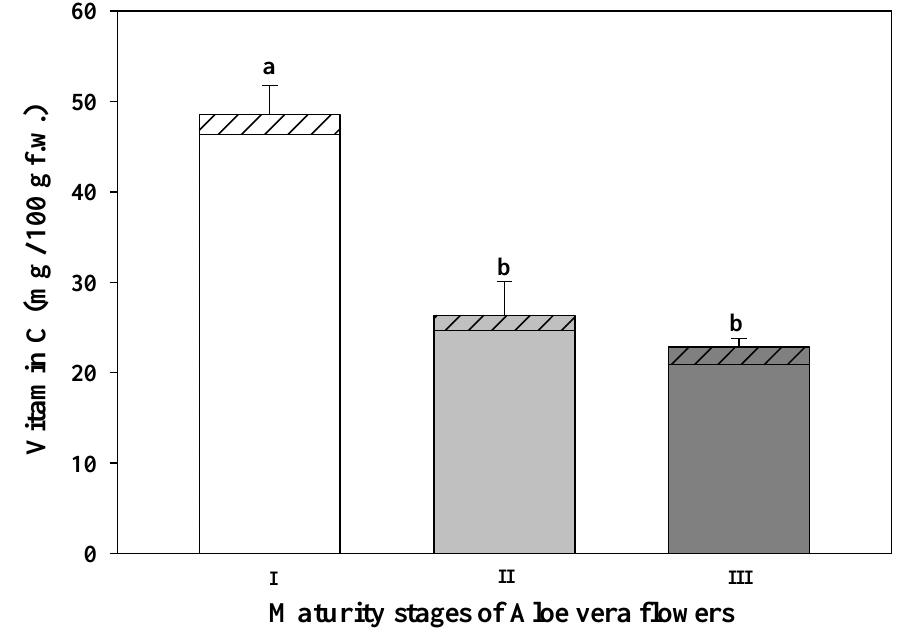
Figure 4. Vitamin C content ( Figure 4. Vitamin C content ( DHAA- dehydroascorbic acid and AA-ascorbic acid) Figure 4. Vitamin C content ( DHAA- dehydroascorbic acid and AA-ascorbic acid) Figure 4. Vitamin C content ( DHAA- dehydroascorbic acid and AA-ascorbic acid) di ff erent maturity stages of Aloe vera flowers. Stage I: immature; stage II: mature; stage III: mature, at different maturity stages of Aloe vera flowers. Stage I: immature; stage II: mature; stage III: mature, at different maturity stages of Aloe vera flowers. Stage I: immature; stage II: mature; stage III: mature, at different maturity stages of Aloe vera flowers. Stage I: immature; stage II: mature; stage III: mature, with flowers buds opened (mean ± SD, n = 3). a-b Di ff erent letters show significant di ff erences in with flowers buds opened (mean ± SD, n = 3). a-b Different letters show significant differences in with flowers buds opened (mean ± SD, n = 3). a-b Different letters show significant differences in with flowers buds opened (mean ± SD, n = 3). a-b Different letters show significant differences in ascorbic acid ( p < 0.05) among the maturity ascorbic acid ( p < 0.05) among the maturity stages. ascorbic acid ( p < 0.05) among the maturity stages. ascorbic acid ( p < 0.05) among the maturity stages.